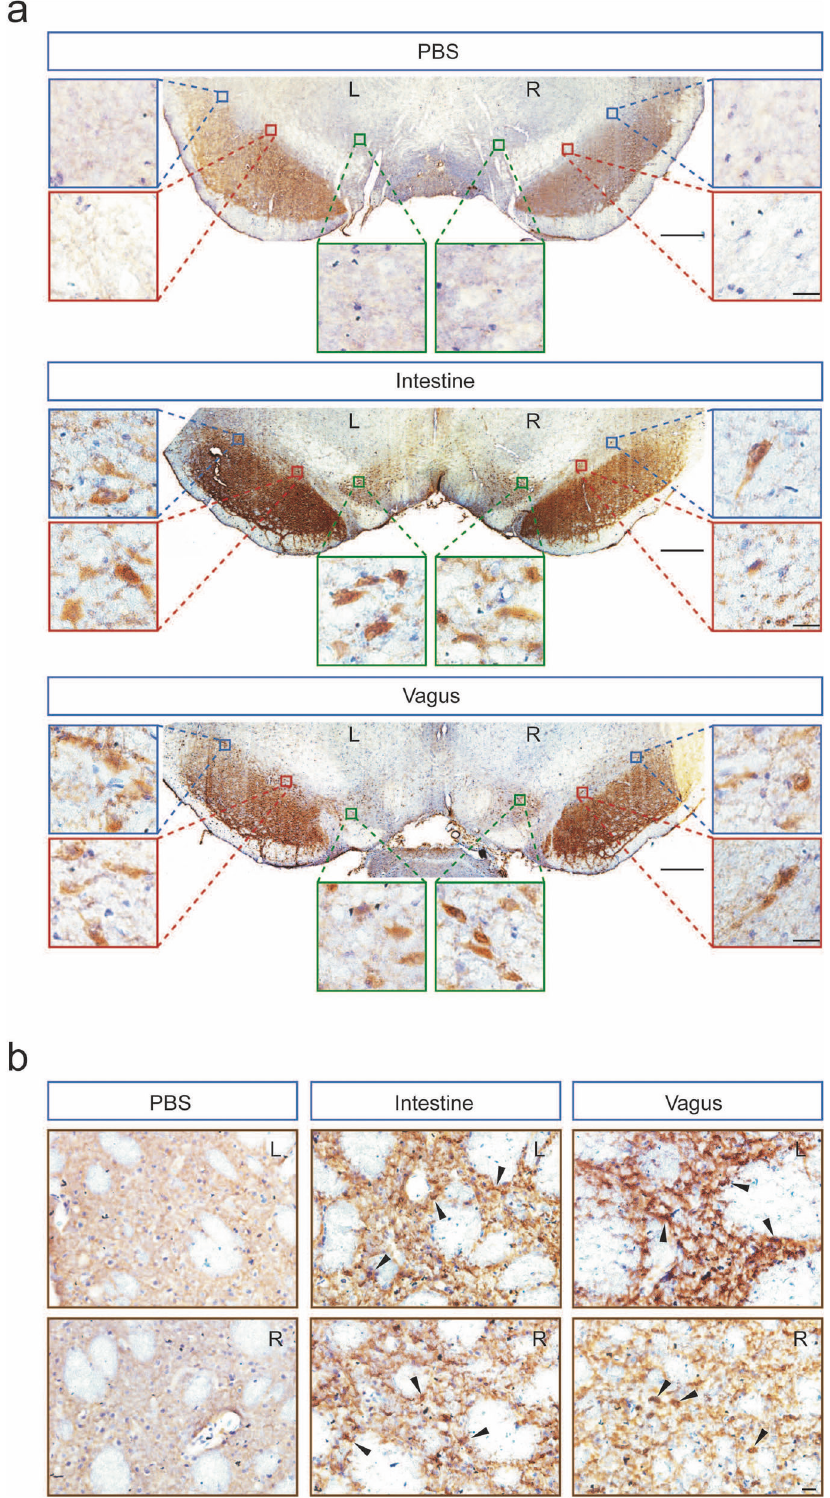
Fig. 3 Increased somatic accumulation of α -syn in the rats injected with intestine or vagus lysate. α -syn is immunoreactive in the neurons and neurites of host midbrain SN ( a ) and STR ( b ) in the rats intrastriatally injected with PBS, intestine lysate, or vagus lysate derived from a post-mortem PD patient. Arrows point to dopaminergic neurons containing a large number of pigmented granules. Scale bars, 200 μ m; high- magni fi cation, 20 μ m. L ipsilateral left brain, R contralateral right brain.